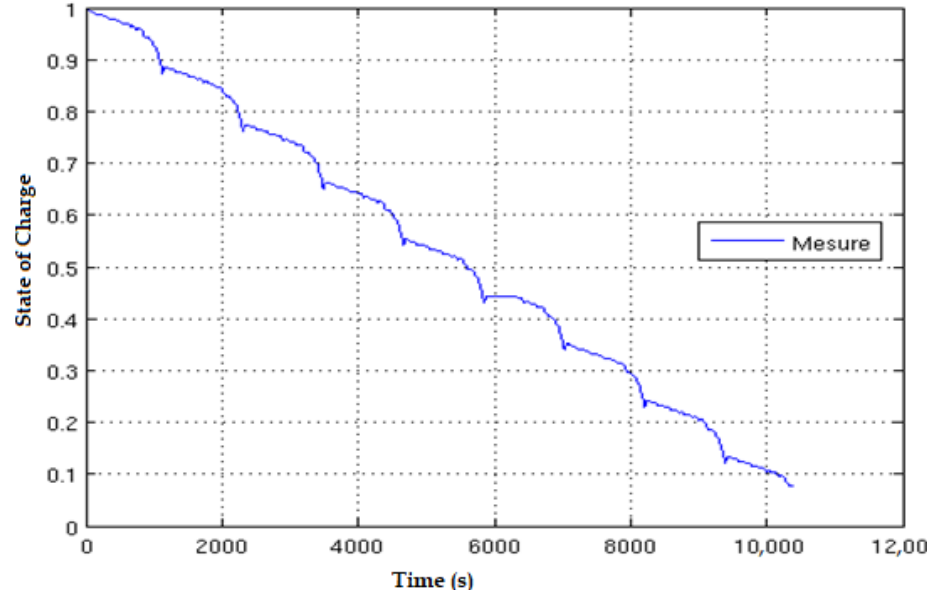
Figure 11. SOC evolution within the 8 NEDC cycles.